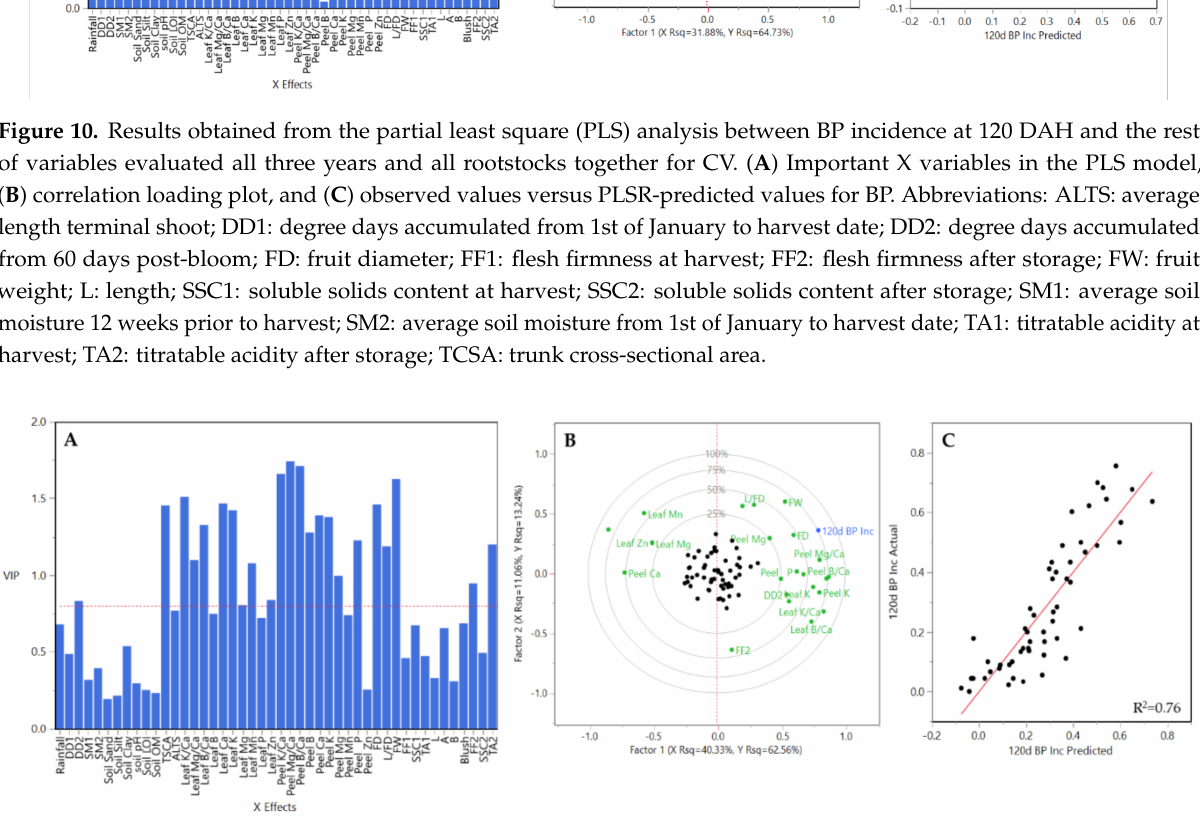
Figure 11. Results obtained from the partial least square (PLS) analysis between BP incidence at 120 DAH and the rest of variables evaluated all three years and all rootstocks together for HV. ( A ) Important X variables in the PLS model, ( B ) correlation loading plot, and ( C ) observed values versus PLSR-predicted values for BP. Abbreviations: ATS: